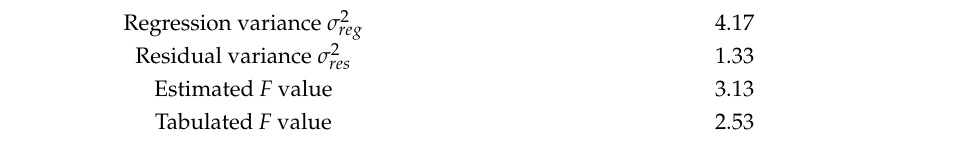
Table 2. Fisher’s test results for regression